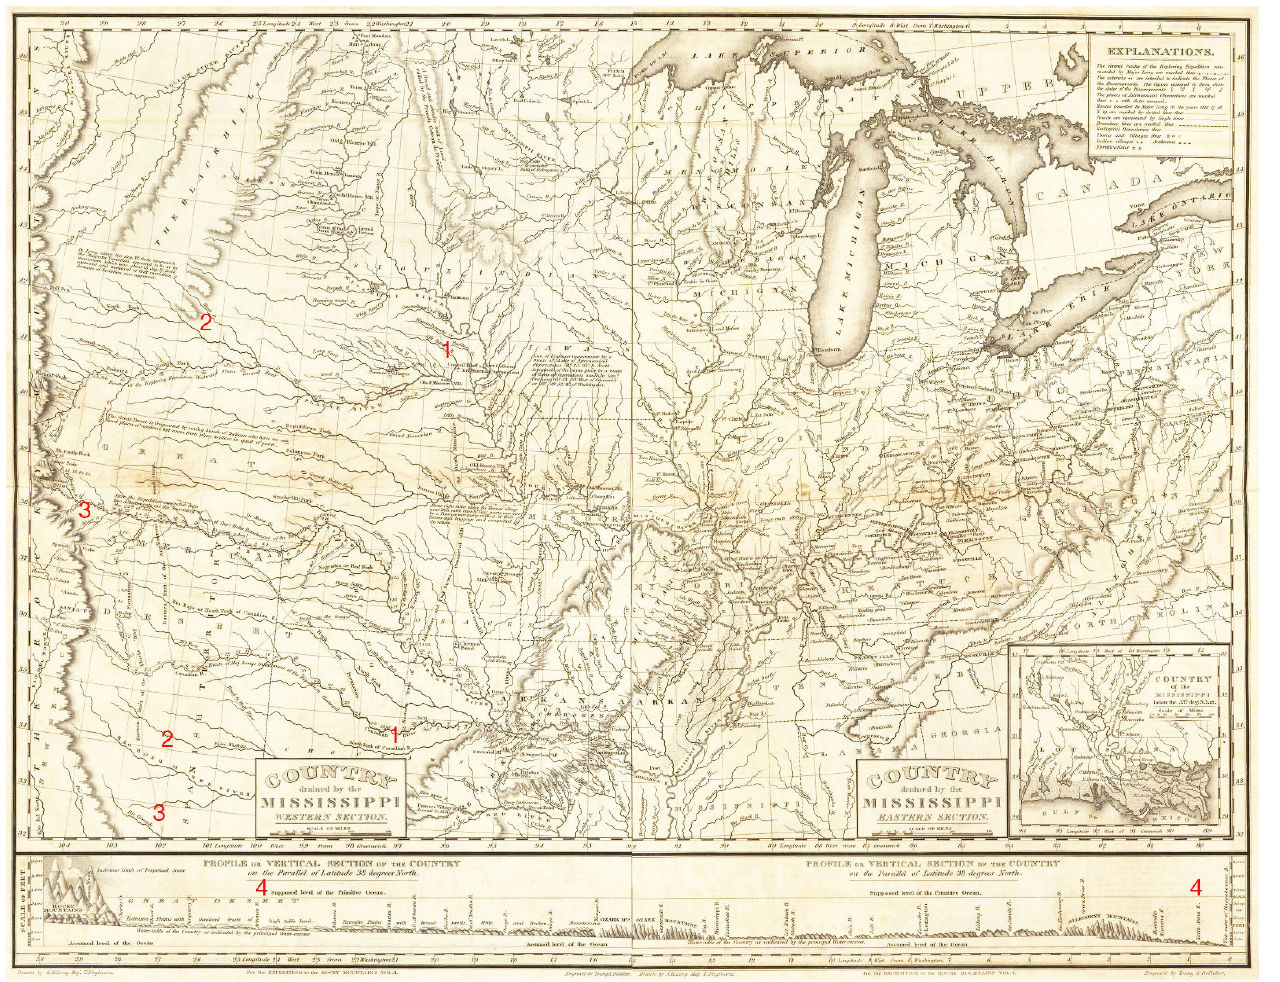
Figure 4. Country drained by the Mississippi River (James, 1822a). Text on map accompanying lines labeled: 1 – “Western limit of the Limestone and Coal strata connected with the Ozark Mountains”, 2 – “Eastern limit of the Argillaceous Sandstone”, 3 – “Eastern limit of the Floetz Trap [basalt] Formation”, 4 – “Supposed level of the Primitive Ocean”.